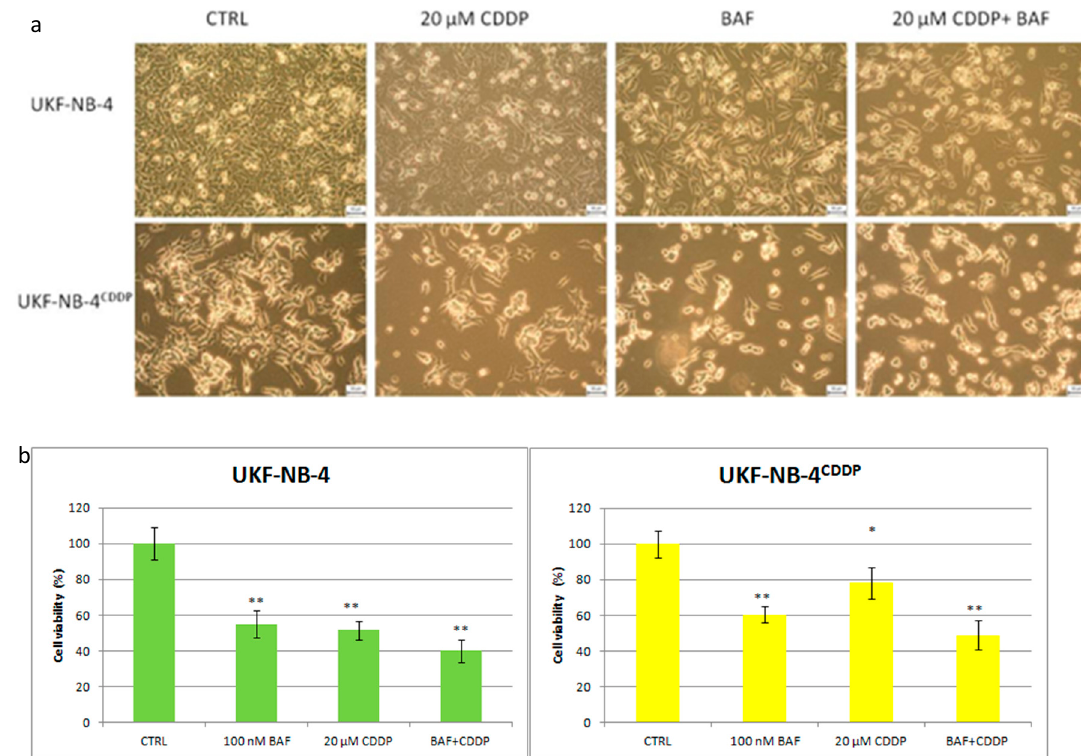
Figure 2. Detection of cellular viability by morphology-original magnification 100 × ( a ) and Alamar Blue- ( b ) both in UKF-NB-4 sensitive and cisplatin-resistant UKF-NB-4 CDDP neuroblastoma cells treated with 100 nM bafilomycin A, 20 μ M cisplatin, or a combination of both for 24 h. * p < 0.05 ** p < 0.01 CTRL- control, BAF- bafilomycin A, CDDP- cisplatin.